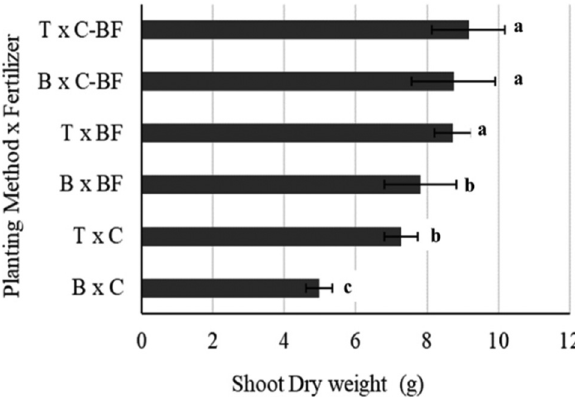
Figure 3: The SDW of rice crops grown with di ff erent planting methods and combined fertilizer treatments 60 days after planting. The planting methods were transplanting ( T ) and broadcasting ( B ) . Fertilizer combination consisted of NPK and urea ( control, C ) ; NPK, Urea, biofertilizer ( BF ) ; NPK, Urea, compost and biofertilizer ( C - BF ) . Error bars represent the standard error of the mean. Di ff erent letters were indicated signi fi cantly di ff erent based on the LSD test ( p ≤ 0.05 ) .